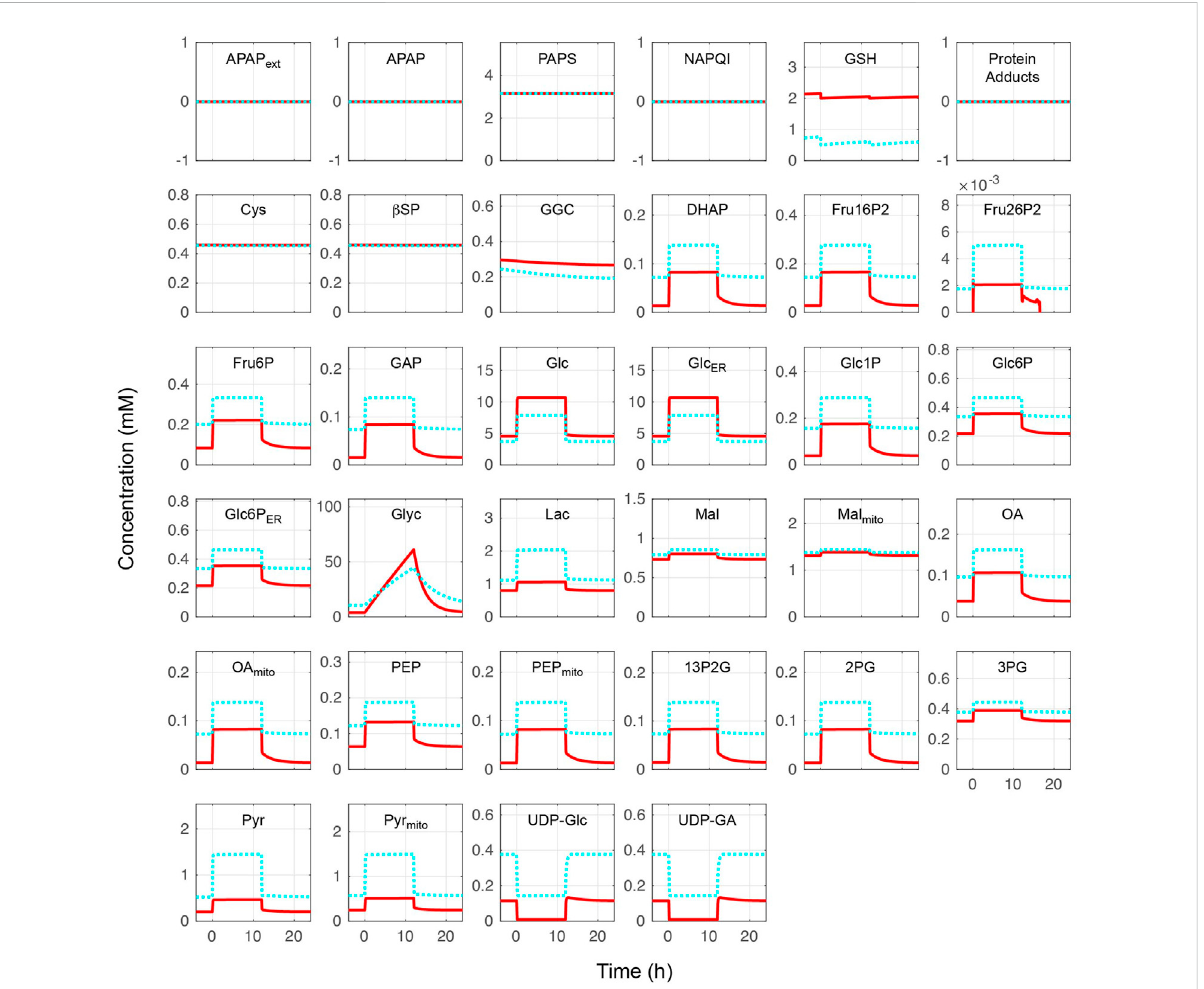
FIGURE 2 Metabolite concentrations without acetaminophen administration. Hepatocytes were in a feeding state from 0 to 12 h and in a fasting state for the rest of the simulation time. The external (blood) glucose levels were set to 4 and 11 mM for the fasting and feeding states, respectively. The solid red lines and blue dotted lines indicate the periportal and pericentral regions, respectively. The de fi nitions of the abbreviations are listed in Supplementary